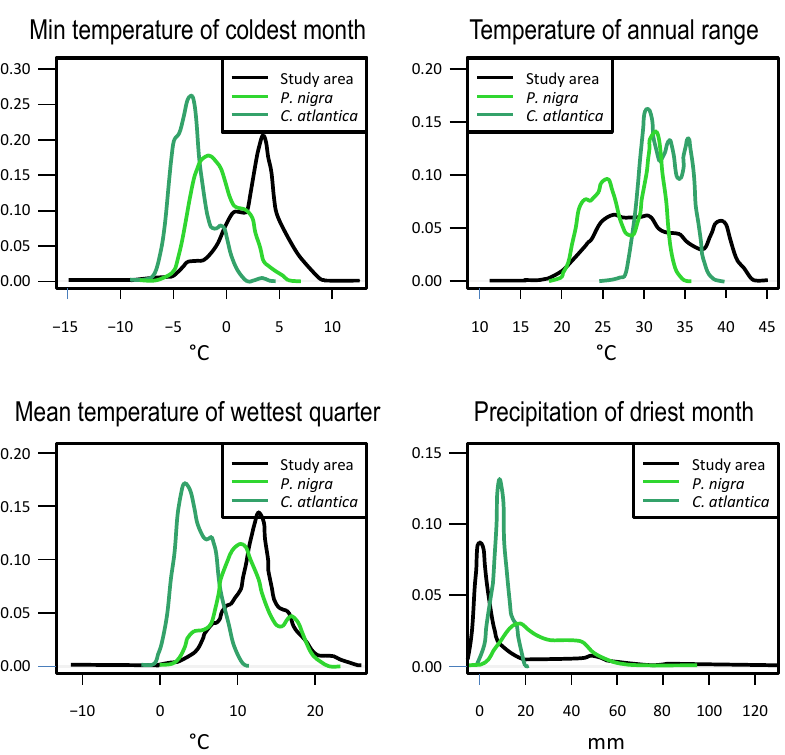
Figure A3. Density curves of the predictor variables for Pinus nigra , Cedrus atlantica and the back- ground in the study area (see Figure